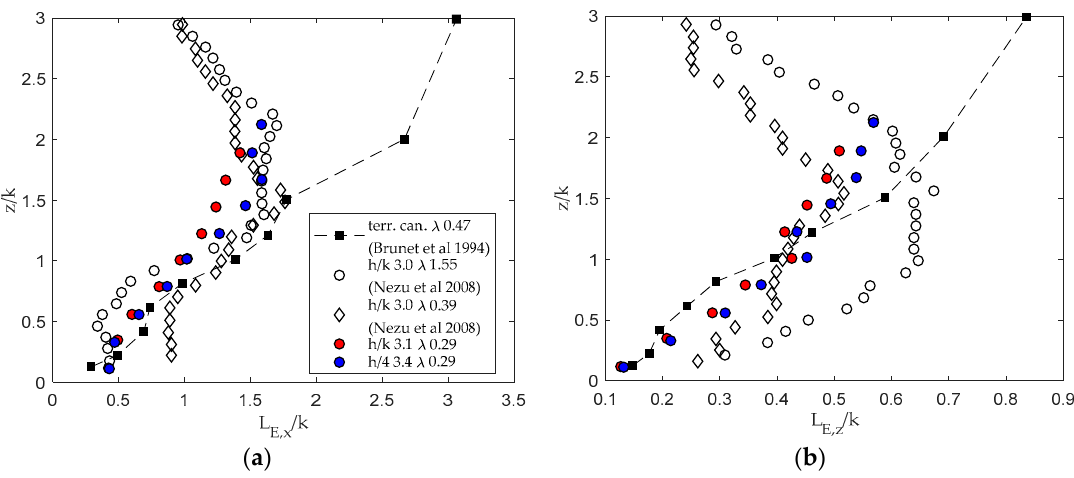
Figure 13. Comparison with analogous literature calculation of integral length scales [6,46]: ( a ) integral length scale profile along the vertical direction for the x component; ( b ) integral length scale profile along the vertical direction for the z component. In the plot, only the profiles evaluated for the two highest submergence conditions are reported.